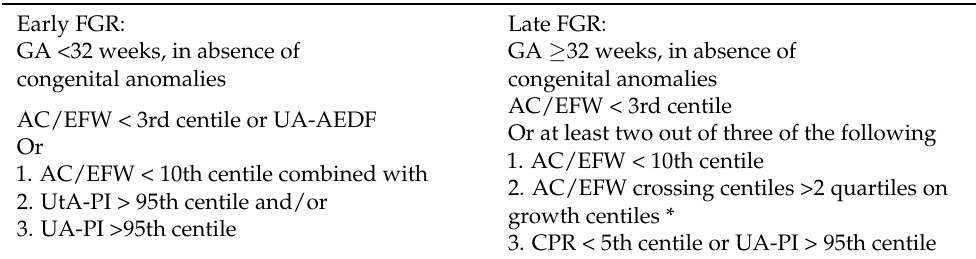
Table 12. Consensus-based definitions for early and late fetal growth restriction